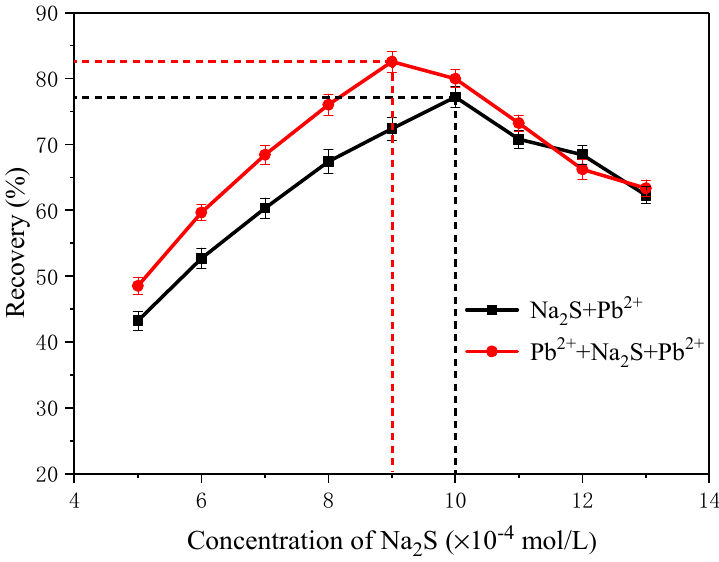
Figure 3. Flotation recovery of hemimorphite with respect to the Na 2 S · 9H 2 O concentration with and without Pb 2 + pretreatment (at a pH of 10.5).